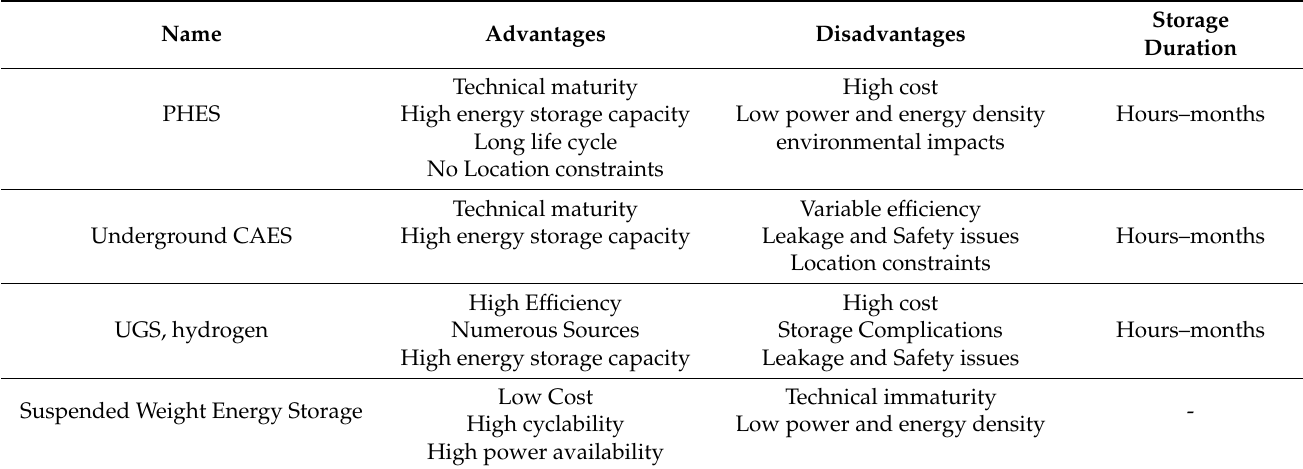
Table 3. Advantages and disadvantages storage technology